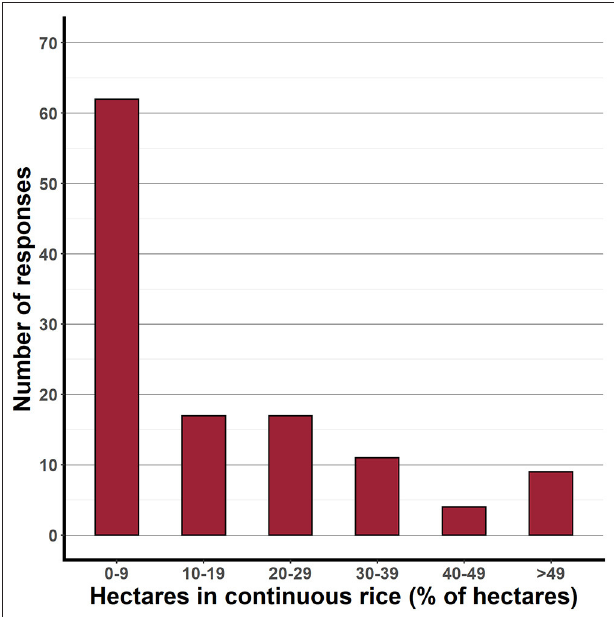
FIGURE 3 | Percentage of continuous rice hectares for 3 consecutive years or more ( n =